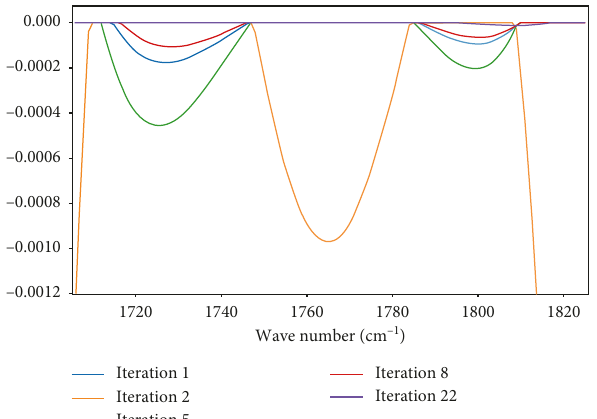
Figure 3: Visual representation of the algorithm. Evolution of the negative part of the second derivative of the bone spectrum be- tween the MMA peak of interest boundaries (1706cm − 1 and 1826cm − 1 ) through the iterations. Each iteration corresponds to the subtraction of the MMA-embedded bone spectrum minus the weighted MMA spectrum (the weight changes with each iteration). Note. An iteration is not always better than the previous one (e.g., iterations 1 and 2), but it tends nonetheless to converge to the expected result (e.g., iteration 22), which is the convexity of the spectrum between the 1706cm − 1 and 1826cm − 1 boundaries. The final result of the MMA removal can be observed in Figure 1 (the MMA contribution, including the 1730cm − 1 peak, in the bone spectrum is